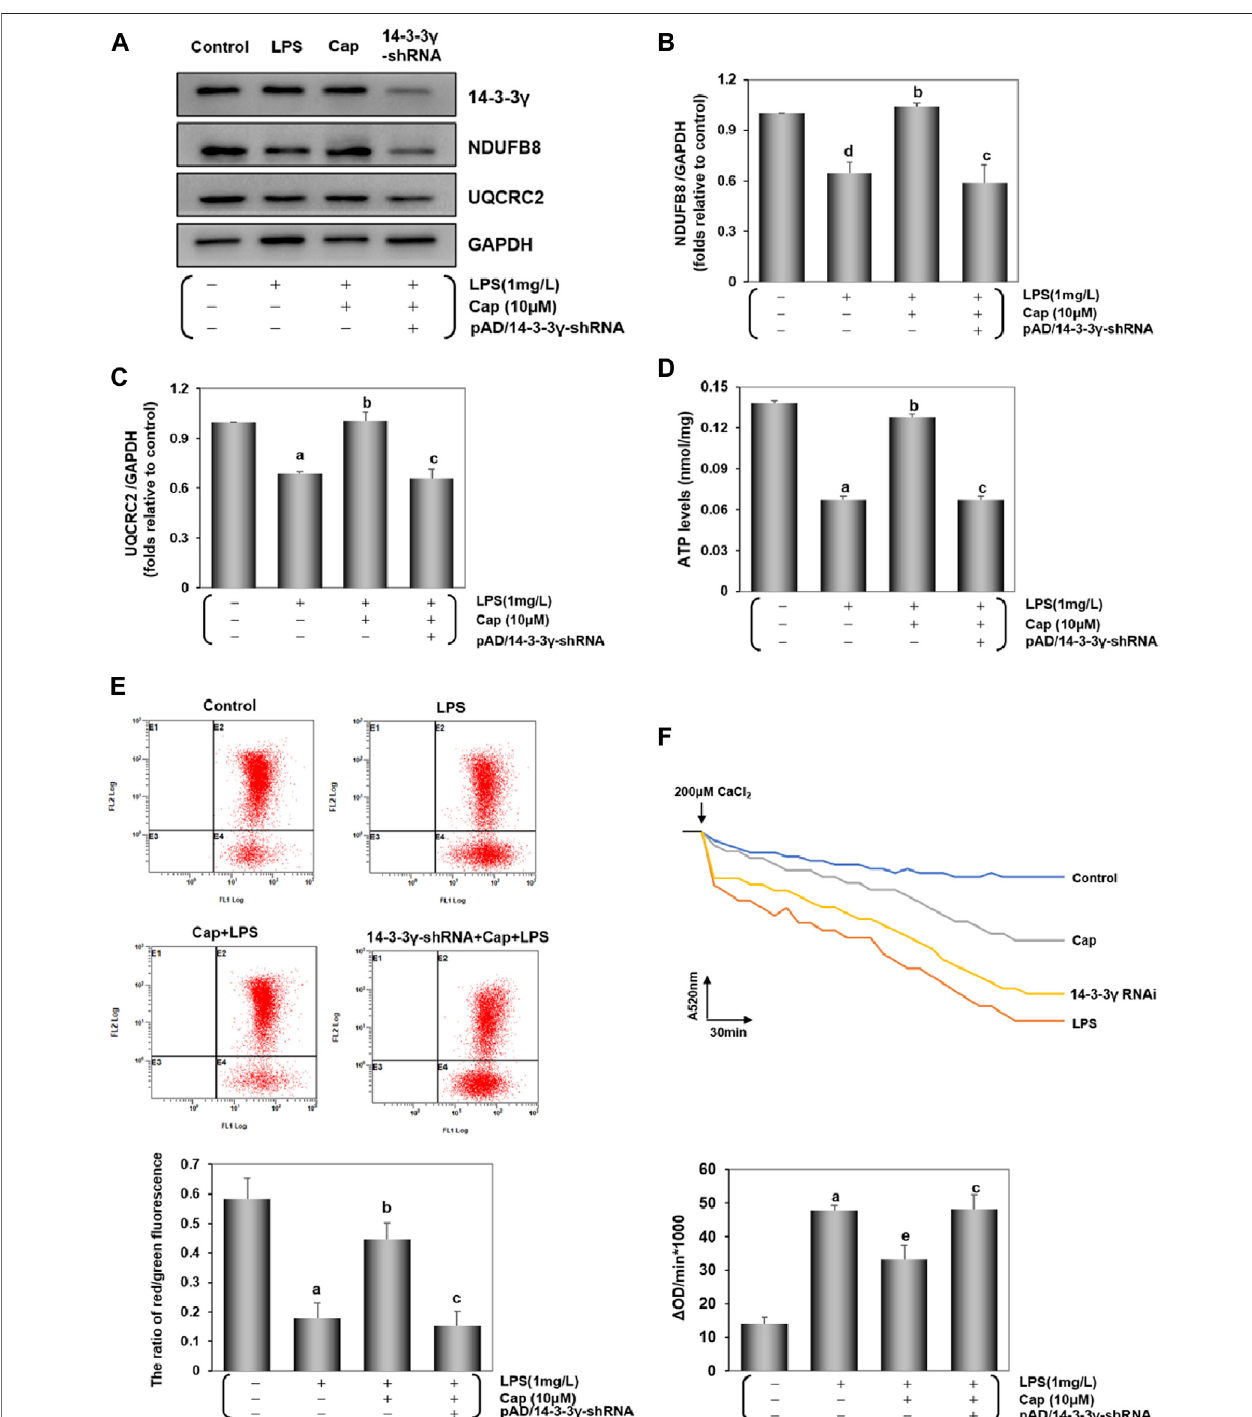
FIGURE7| CapmaintainsmitochondrialfunctionbyregulatingmitochondrialbioenergeticsincardiomyocytesafterLPSchallenge. (A) Therepresentativewestern blot bands of NDUFB8 and UQCRC2 expression in the cardiomyocytes. (B) and (C) The relative band intensity of NDUFB8 and UQCRC2 expression in the cardiomyocytes. (D) Cardiomyocyte ATP levels were measured by fi re fl y luciferase assay. (E) Levels of MMP were detected by JC-1, and red/green fl uorescence ratio indicated MMP levels. (F) Mitochondrial swelling by Ca 2+ -induced cells was used for measuring mPTP opening. The changes in absorbance values at 520 nm per minute were recorded and the mPTP opening levels are shown by fl uctuations in absorbance ( Δ OD (cid:2) A520 0min -A520 30min ). Values are presented as mean ± SEM. For fi ve individual experiments, a: P < 0.01 vs. the control group; b: P < 0.01 vs. the LPS group; c: P < 0.01 vs. the Cap+LPS group. d: P < 0.05 vs. the control group; e: P < 0.05 vs. the LPS